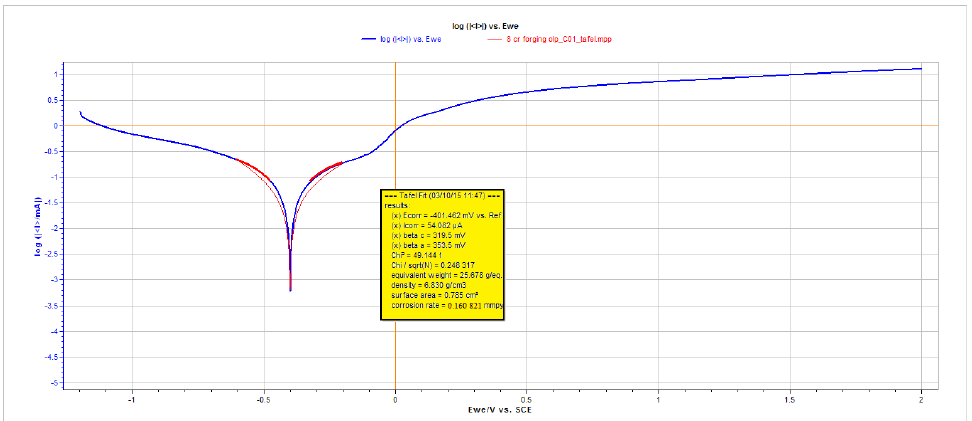
Figure 3: Tafel graph for 8% Cr